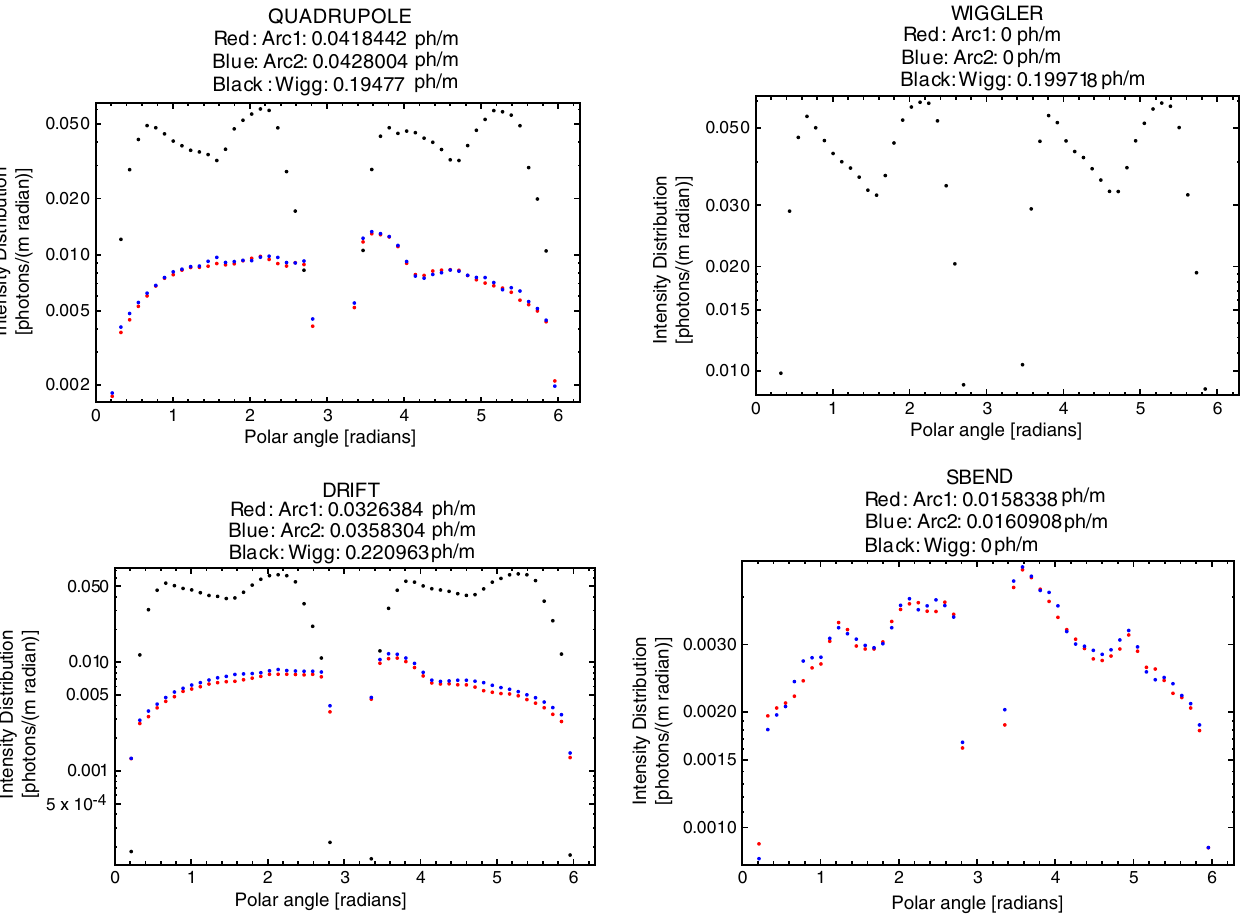
FIG. 17. Photon absorption distributions in different magnetic environments (QUADRUPOLE, WIGGLER, DRIFTand SBEND) and ring regions (Arc1, Arc2, and Wiggler) for the ILC damping